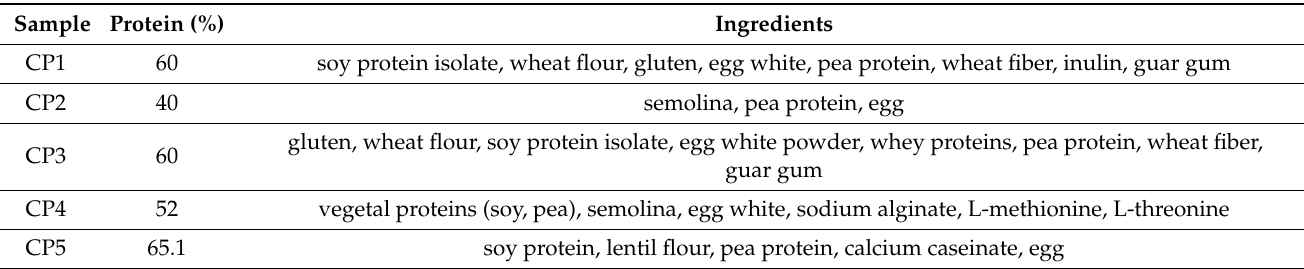
Table 1. Protein content and ingredients of commercial high-protein pasta (CP).